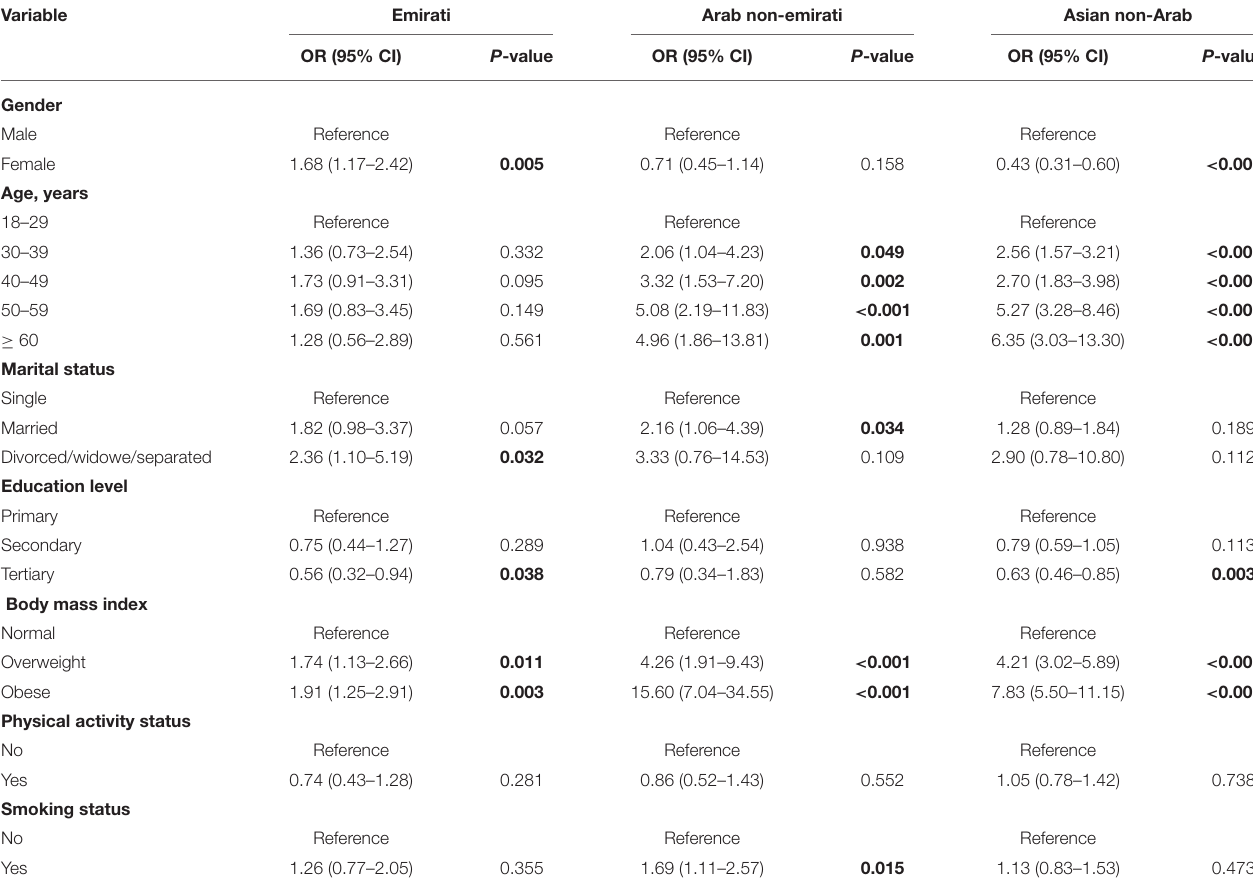
TABLE 4 | Binary logistic regression models for the predictors of metabolic syndrome by ethnicity, OR (95% CI).